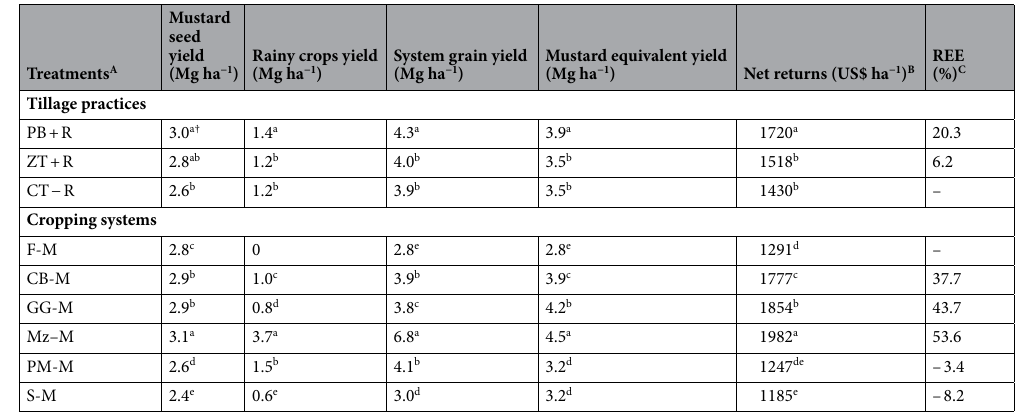
Table 1. Crop yields, system productivity and economics of CA-based Indian mustard systems (3 years mean). † Means followed by a similar lowercase letters within a column are not significantly different at 0.05 level of probability using DMRT. A Refer to Table 7 for treatment description. B US$ = 70.34 INR. C Relative economic